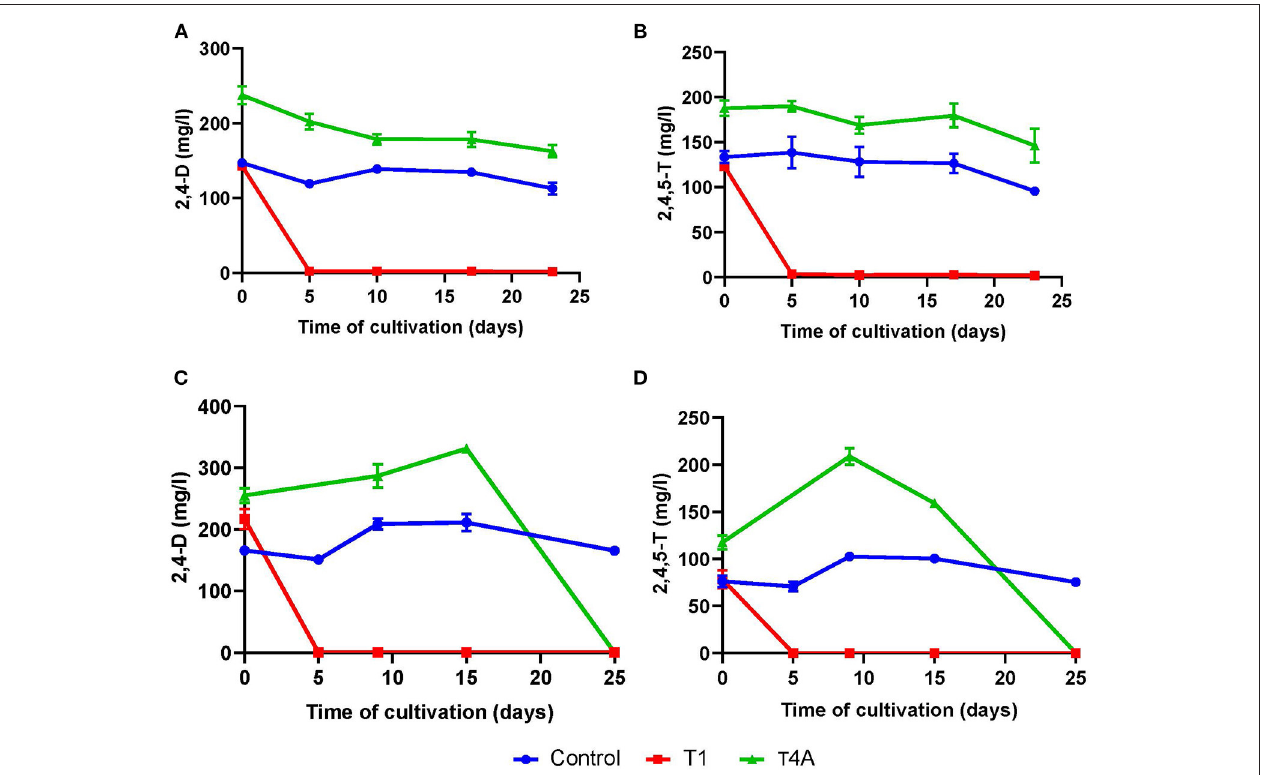
FIGURE 1 | Degradation of 2,4-D (A,C) and 2,4,5-T (B,D) in cultures inoculated with T1 (red curves) and T4A (green curves) soil of the 1st enrichment and the 2nd enrichment (C,D) in time. The blue curves are data from the sterilized control flask. Each data point is the average of three independent measurements, and the error bars are their corresponding standard